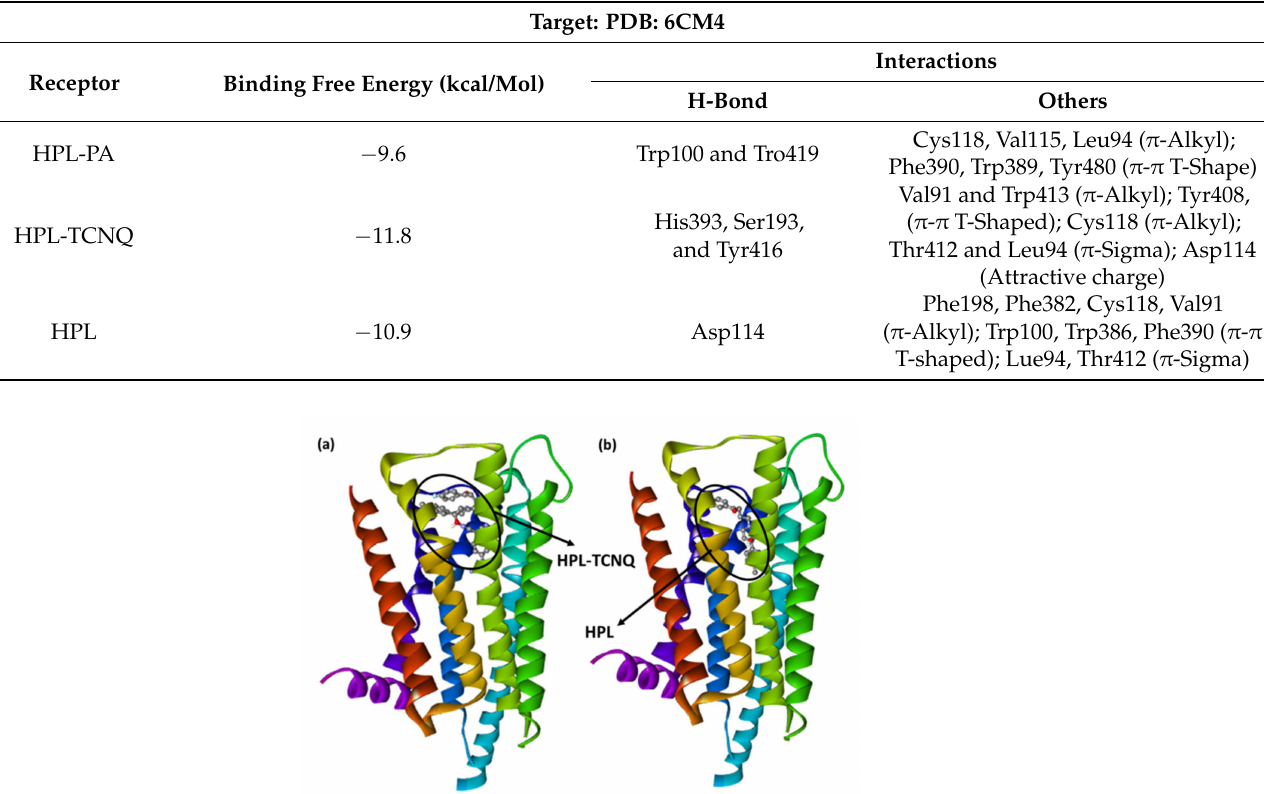
Table 2. Docking score of the ligands and their interactions with dopamine (6CM4).